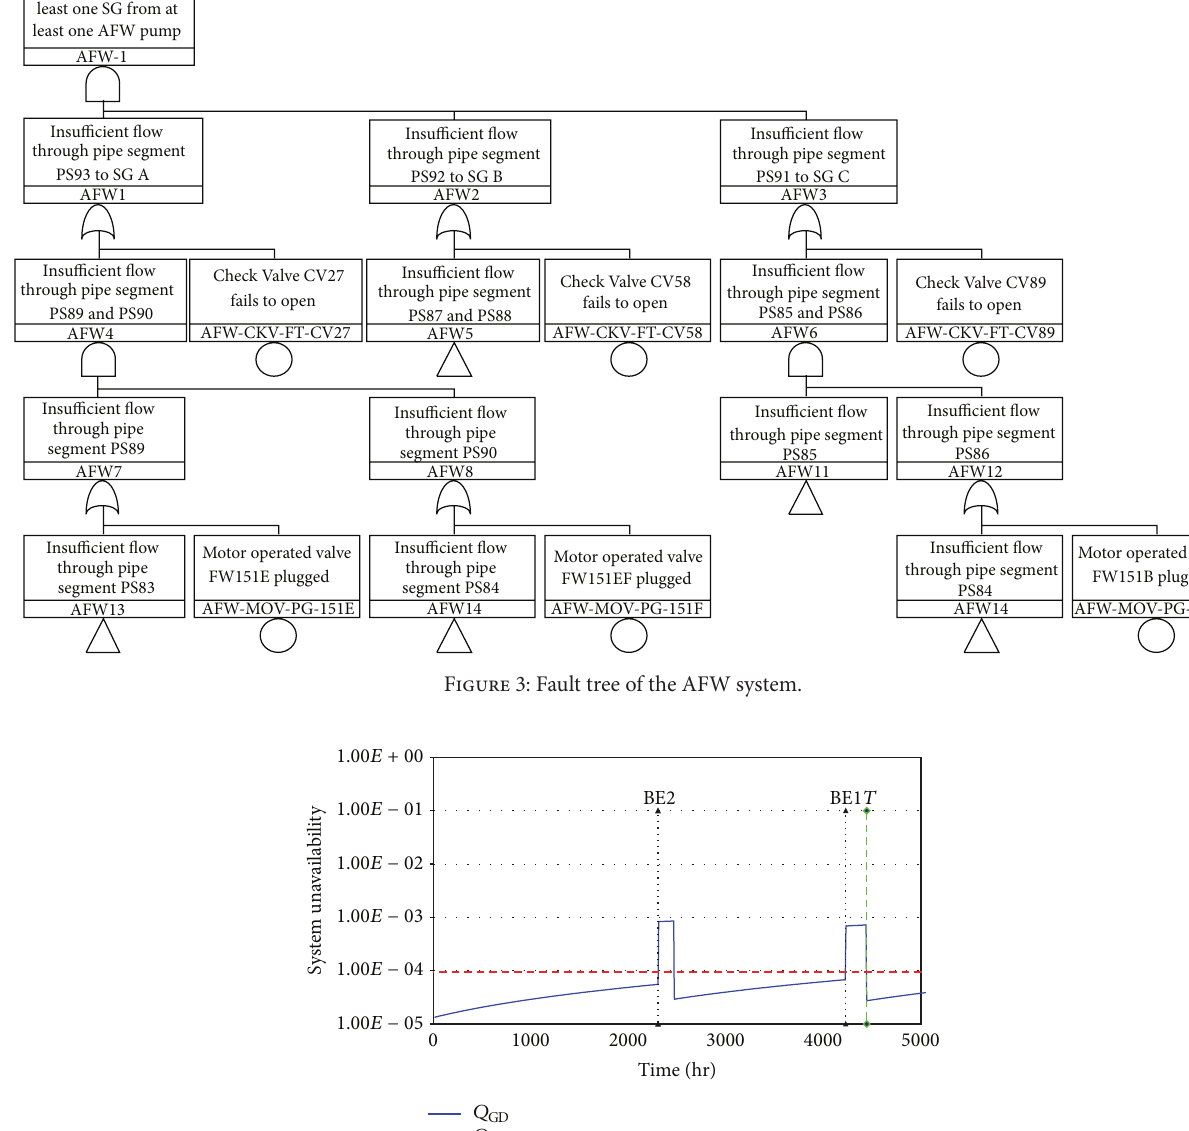
Figure 4: System unavailability of the AFW system over time for case scenario 1.